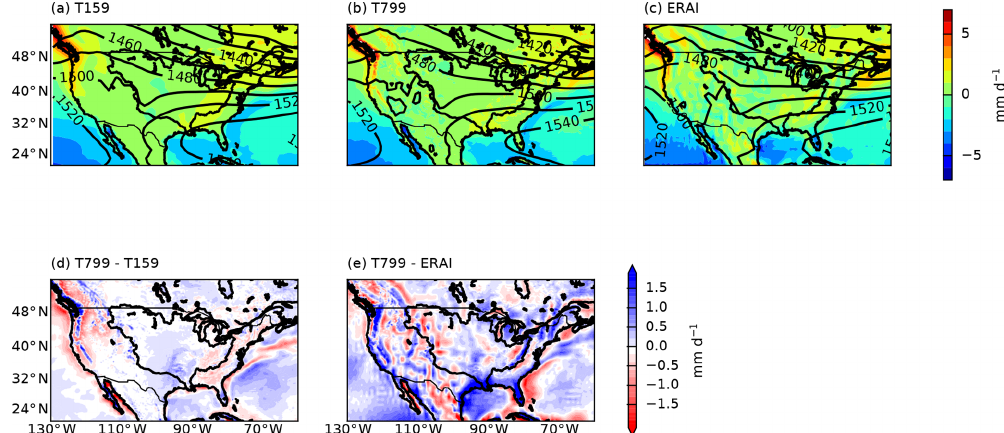
Figure 13. 30-year averages of geopotential height (m) at 850hPa in contour lines and moisture convergence (mmday − 1 ) in colour over the Mississippi basin for (a) the low-resolution GCM (T159), (b) the high-resolution GCM (T799), (c) ERAI, and the difference between (d) high- and low-resolution GCMs (T799–T159) and (e) the high-resolution GCM and ERAI (T799–ERAI).